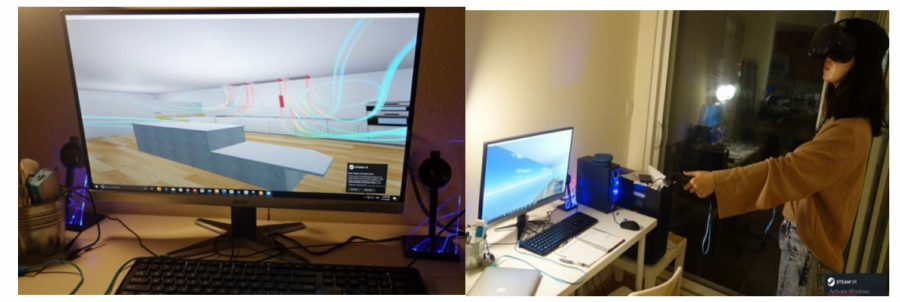
Figure 16. Test using HTC